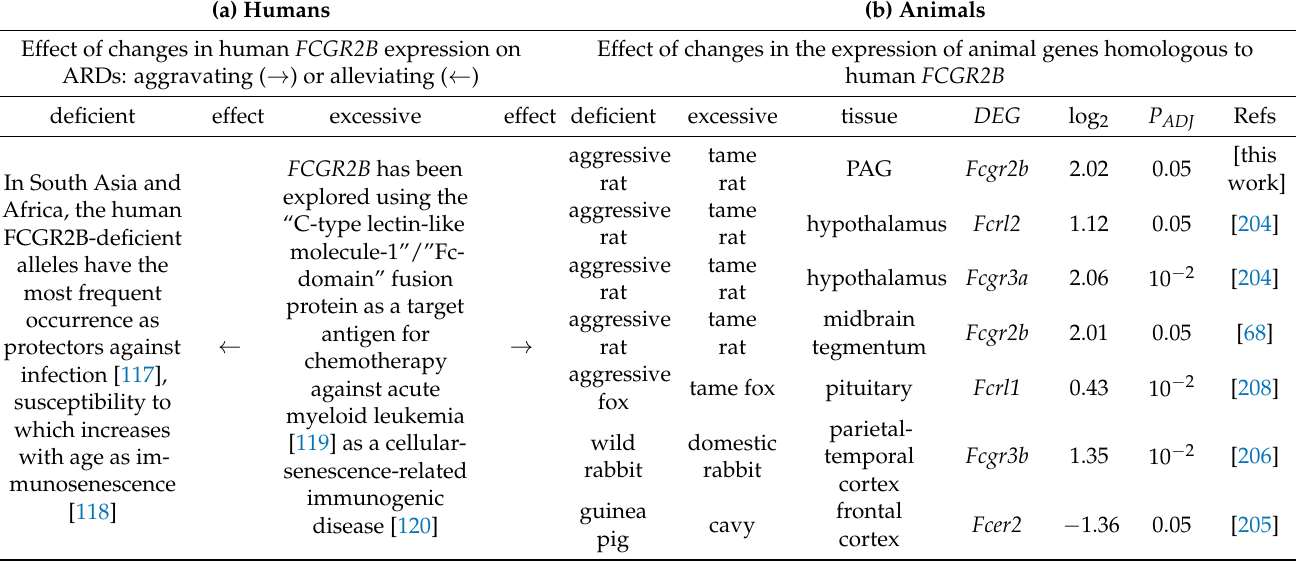
Table 9. Comparison of the effects of unidirectional changes in the expression ( a ) of the human FCGR2B gene on ARD severity in humans and ( b ) of its animal homologs on the microevolutionary events leading to domestic and wild